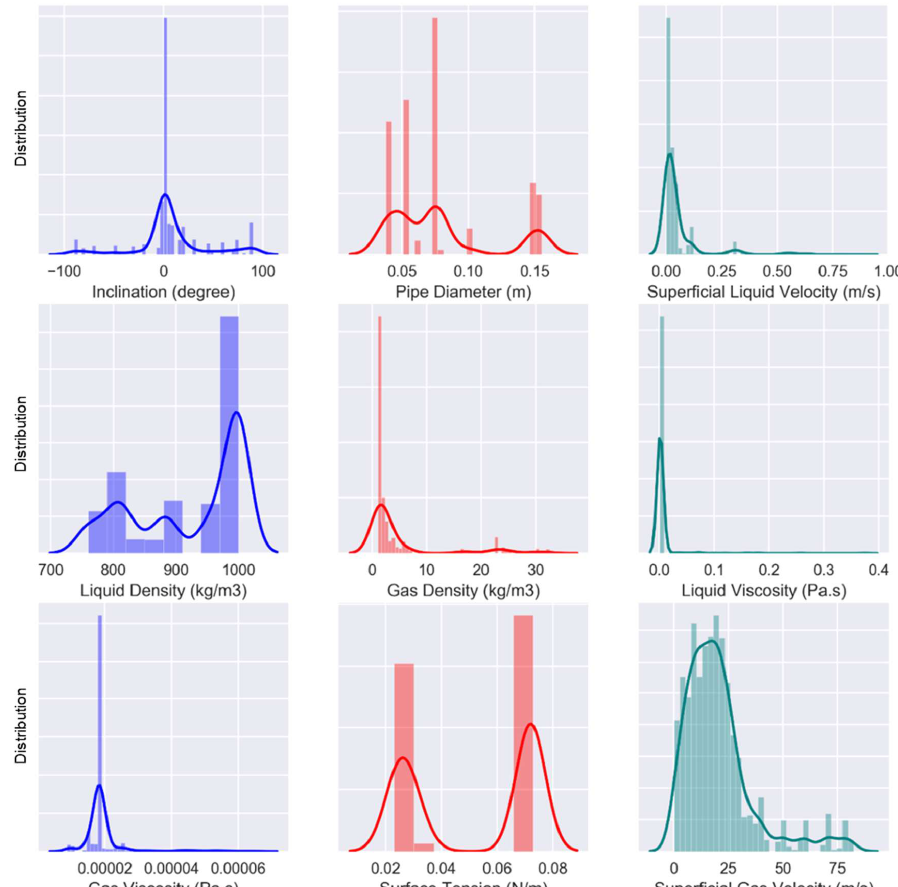
Figure 4. Univariate distribution plot for the entire dataset.